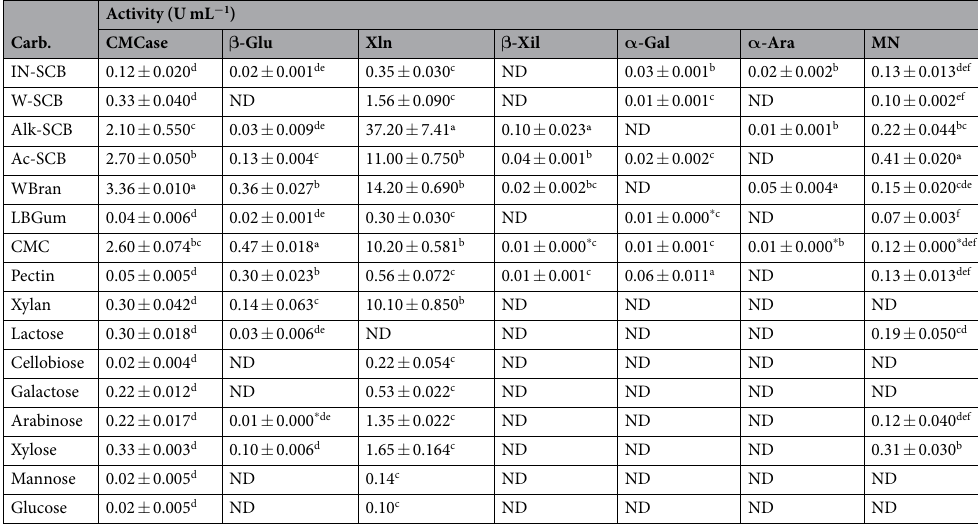
Table 2. Cellulase and hemicelulase activities produced by Chrysoporthe cubensis under submerged fermentation with different carbon sources (Carb.). SCB = sugarcane bagasse; IN-SCB = in natura sugarcane bagasse; W-SCB = washed SCB; Alk-SCB = alkali pretreated SCB; Ac-SCB = acid pretreated SCB; WBran = wheat bran, LBGum = locust bean gum. CMCase = carboxymethylcellulase; β -Glu = β -glicosidase; Xyl = xylanase; β -Xy l = β -xylosidase; α -Ara = α -arabinofuranosidase; α -Gal = α -galactosidase; MN = Mannanase; ND = not detected. Averages followed by the same letter do not differ by the Tukey test at 5% of significance. * Standard deviations lower than 0.001.